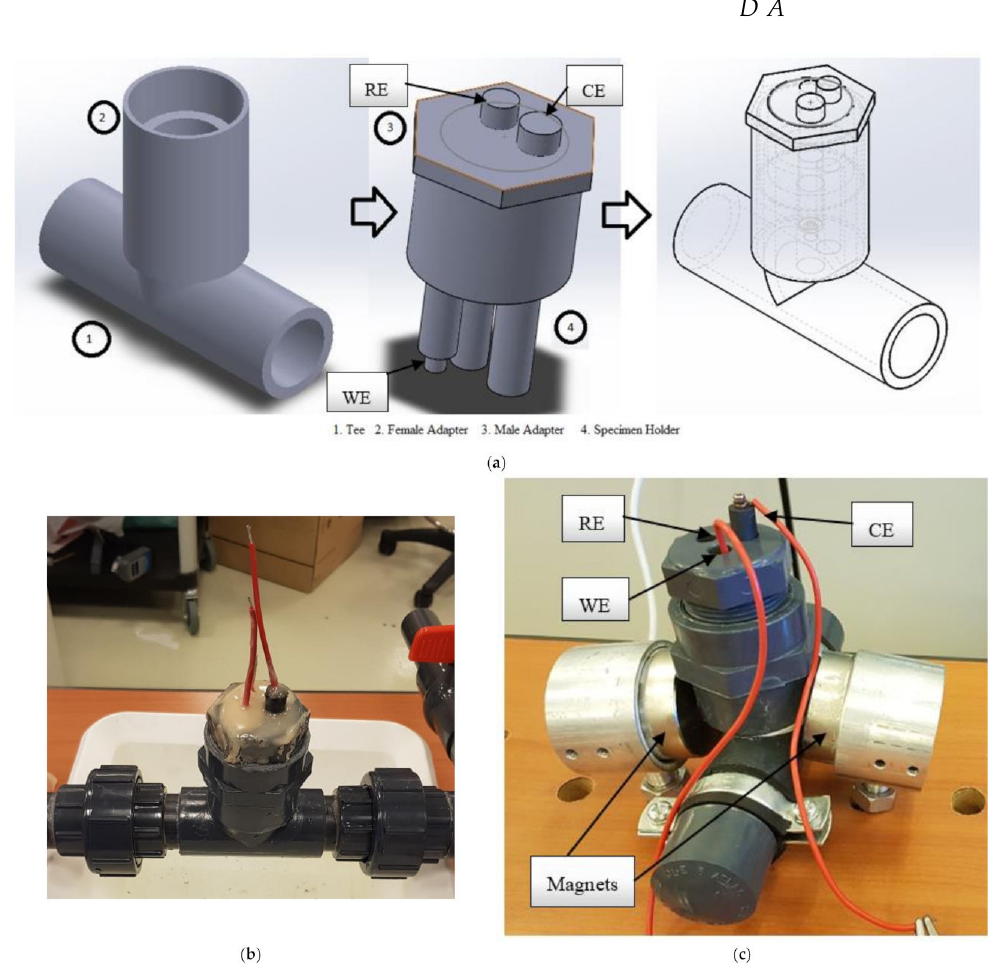
Figure 3. Electrochemical test apparatus ( a ) CAD design ( b ) on flow loop ( c ) with